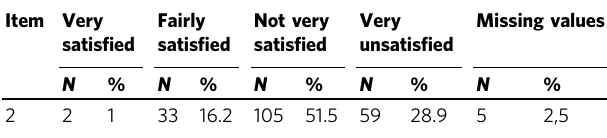
Table 12 Level of satisfaction with information received.